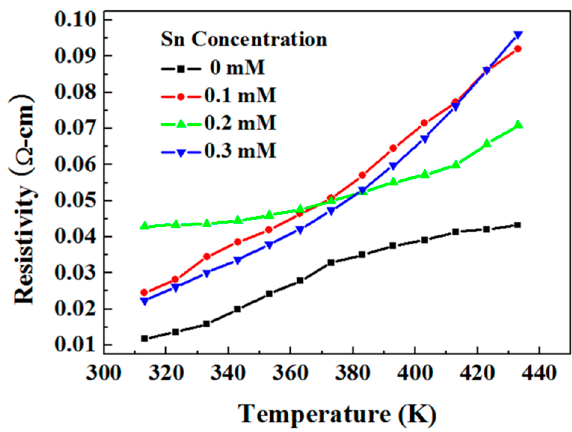
Figure 10. Temperature dependent resistivity of CdO films with different Sn concentrations.